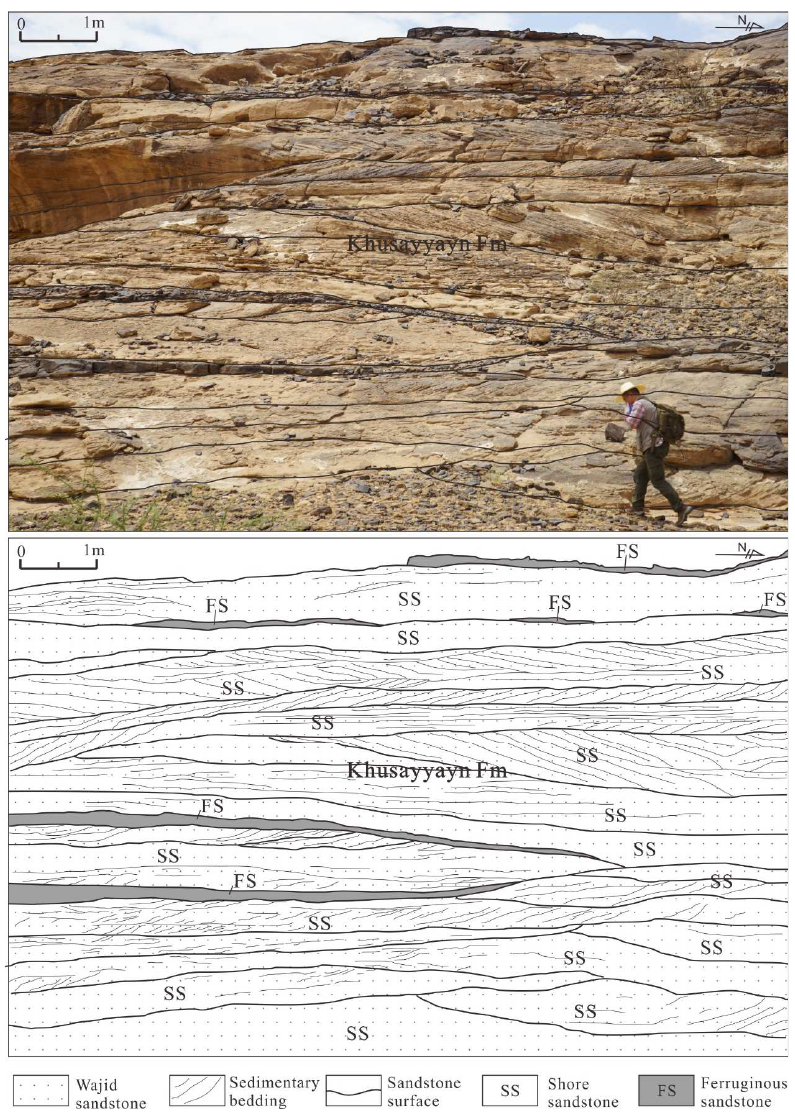
Figure 3. Geological sketch section of the ferruginous sandstone in Khusayyayn Formation of Wajid Group.